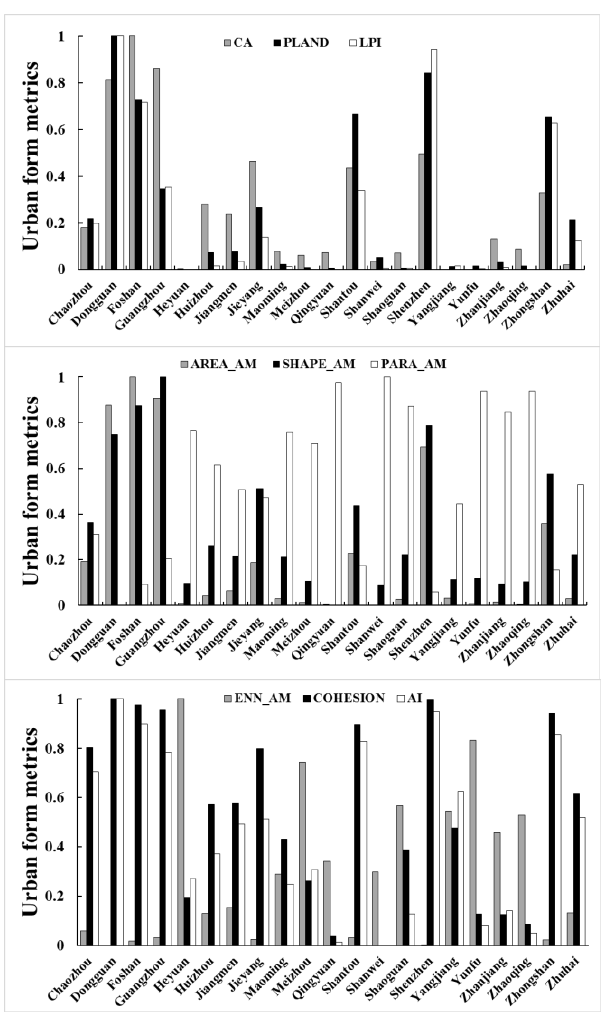
Figure 3. Nine urban form metrics of 21 cities in Guangdong, 2016